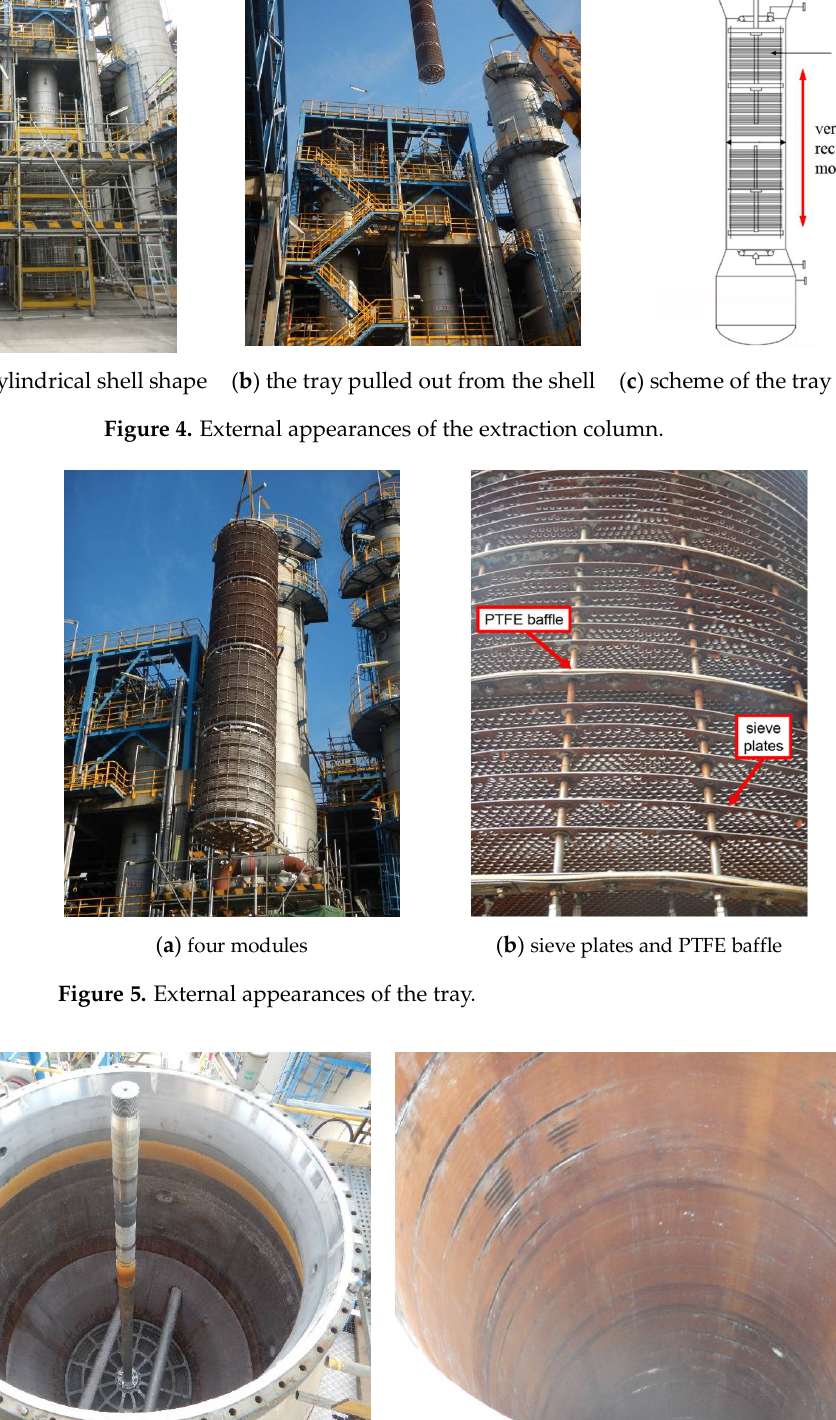
Figure 6. External appearances of the shell inner wall after pulling out the